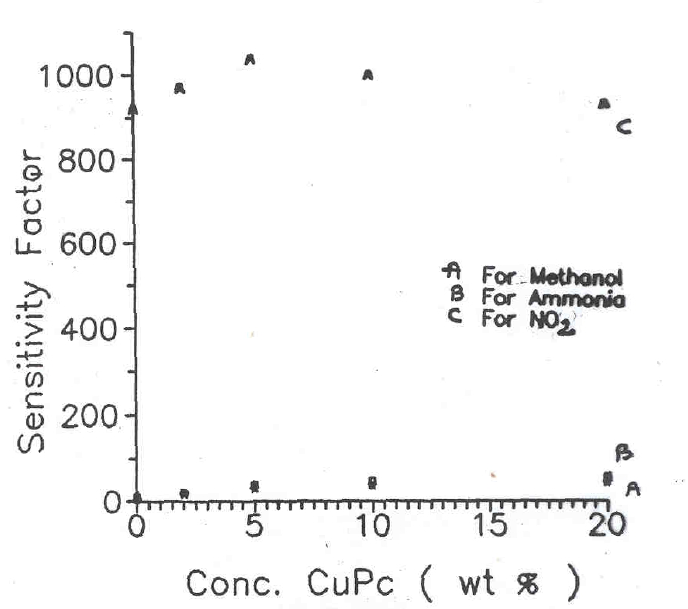
Figure 4. Plots of sensitivity factor versus CuPc concentration for (A) Methanol (B) Ammonia (C) Nitrogen dioxide vapors with PANI-CuPc/ PEO/ CuCl